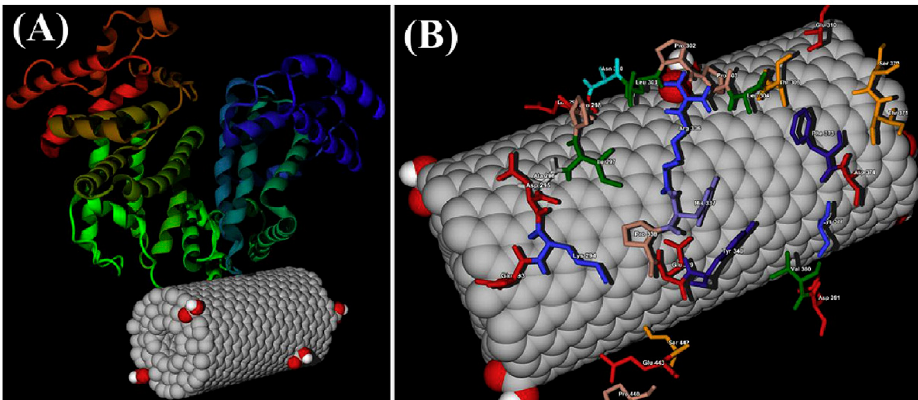
Figure 7. Predicted binding model of BSA molecule on COOH-MWCNTs. ( A ) Lowest docking energy conformation; ( B ) amino acid residues involved in binding interactions. According to the model, 29 amino acid residues of domain II of BSA took part in the binding interactions of BSA with COOH-MWCNTs. The presence of hydrophobic (Ala, Leu, Pro, Phe, and Val) and aromatic (Tyr and Phe) residues suggested that the binding forces between BSA and COOH-MWCNTs include hydrophobic and π - π stacking interactions. Reprinted from [135], with permission from Elsevier.